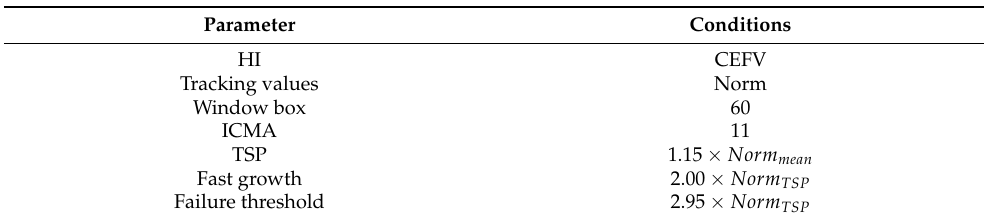
Table 5. FEMTO-ST dataset prediction parameters.